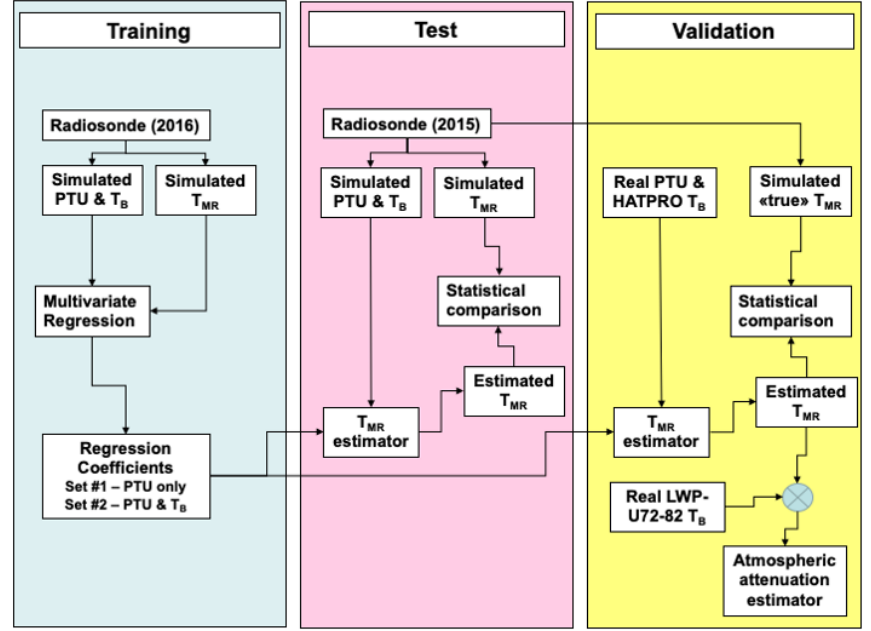
Figure 1. Flowchart of the implemented data